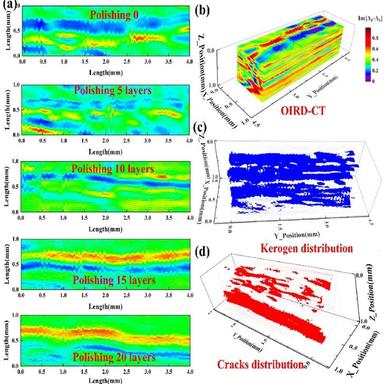
OIRD-CT image of the oil shale and its strips of kerogen and cracks. (a) OIRD images of polished oil shale strips 0, 5, 10, 20, and 15. (b) OIRD-CT image of the oil shale. (c)e(d) OIRD-CT image of the kerogen and cracks in the oil shale.